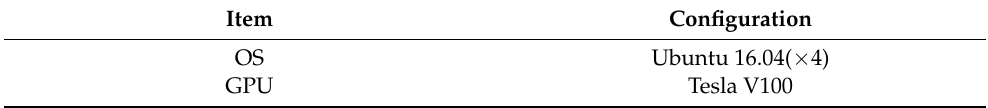
Table 2. Experimental environment.